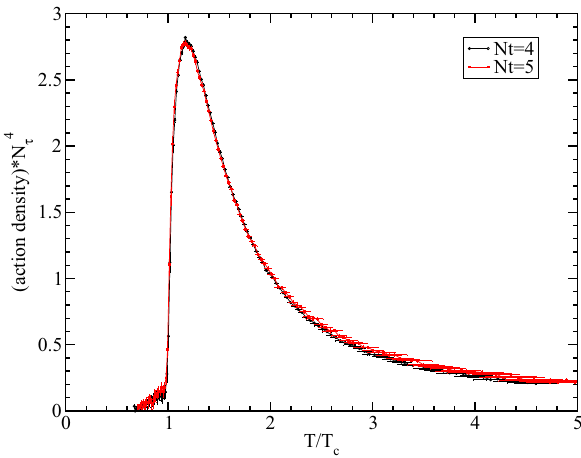
Fig. 10 Action density [ (cid:6) S (cid:7) 0 − (cid:6) S (cid:7) T ] N 4 τ . Note that results obtained at two different lattice spacings are